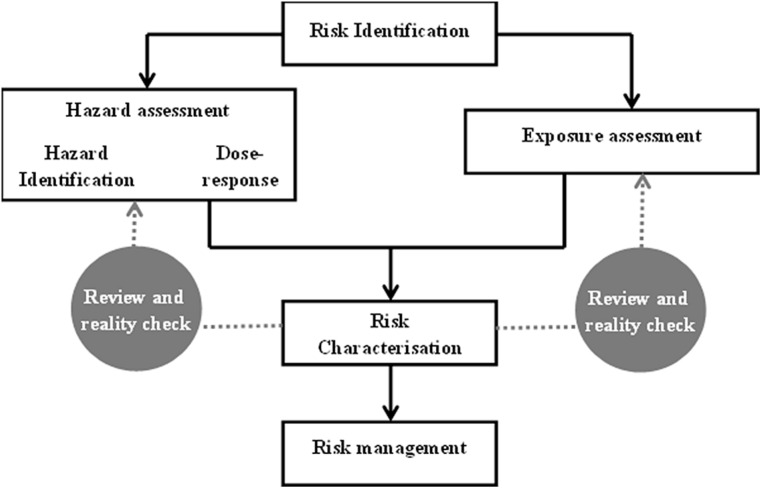
EnHealth risk assessment framework adapted from Priestly et al. (2012).